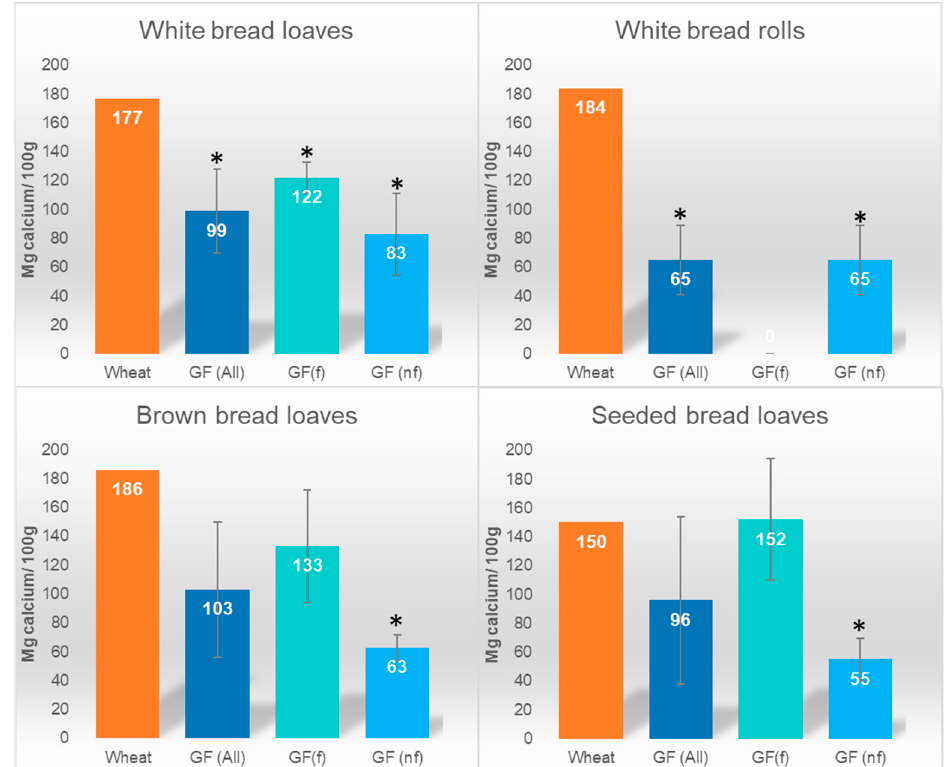
Figure 1. Calcium content of wheat-based and gluten-free (GF) bread products. GF(f): calcium-fortified products, GF(nf): no calcium fortification; calcium fortification category based on information from food label and ingredient list. * p < 0.05 compared with wheat-based bread value.